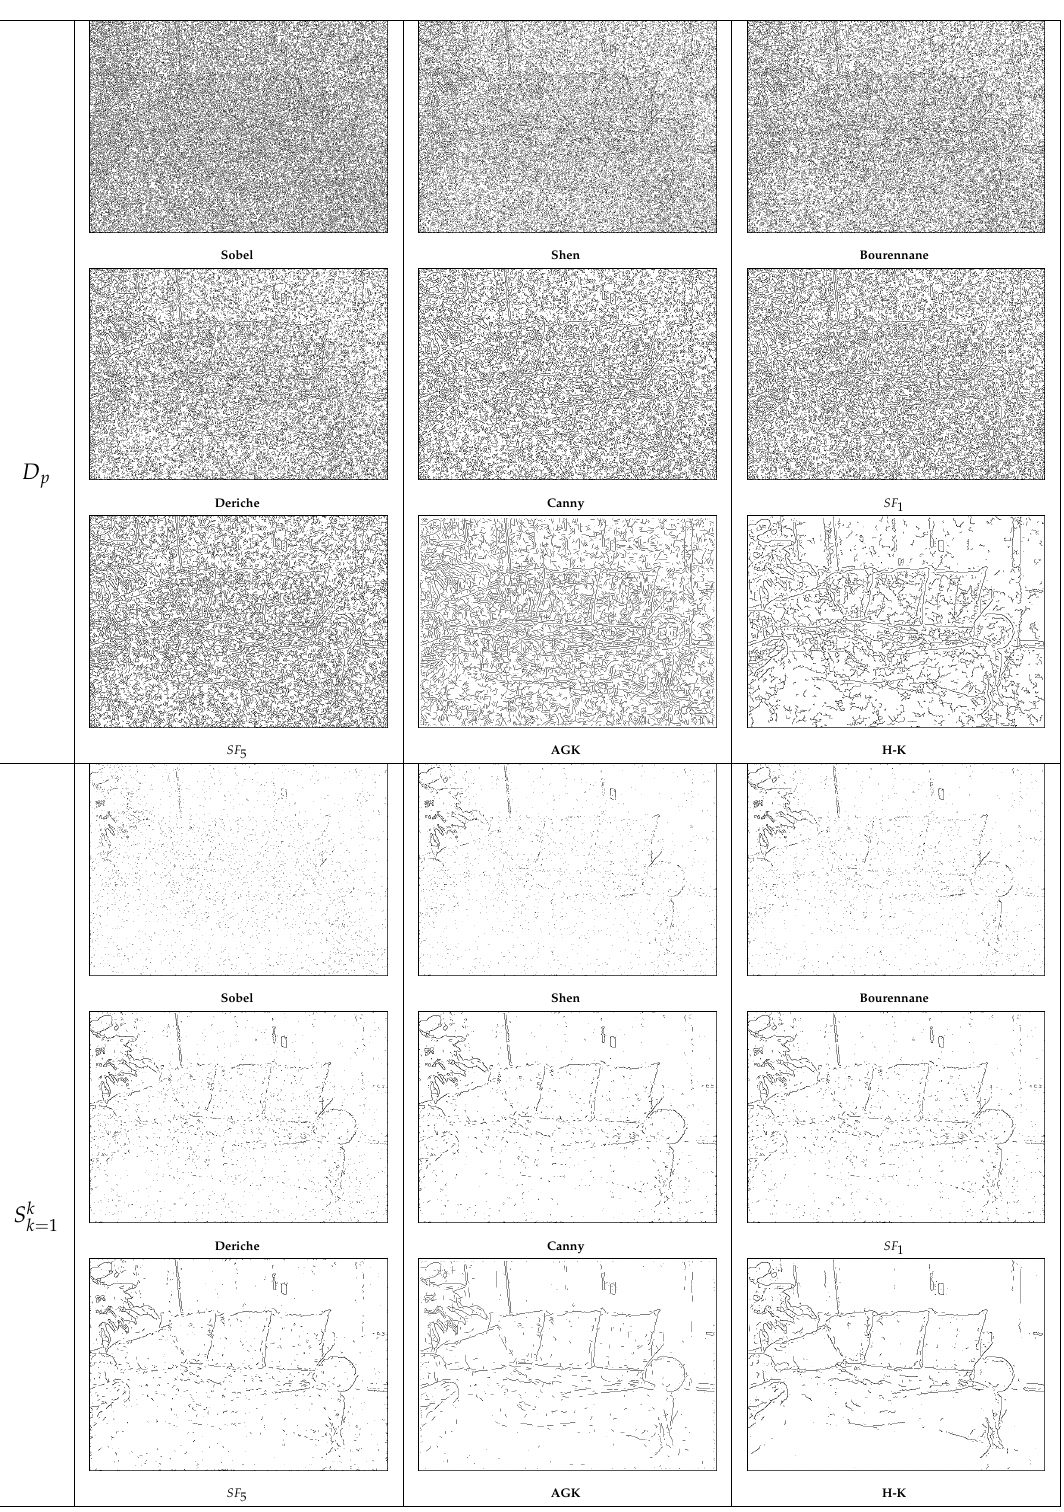
Figure 31. Ideal segmentations for several edge detectors on image 109, PSNR = 14